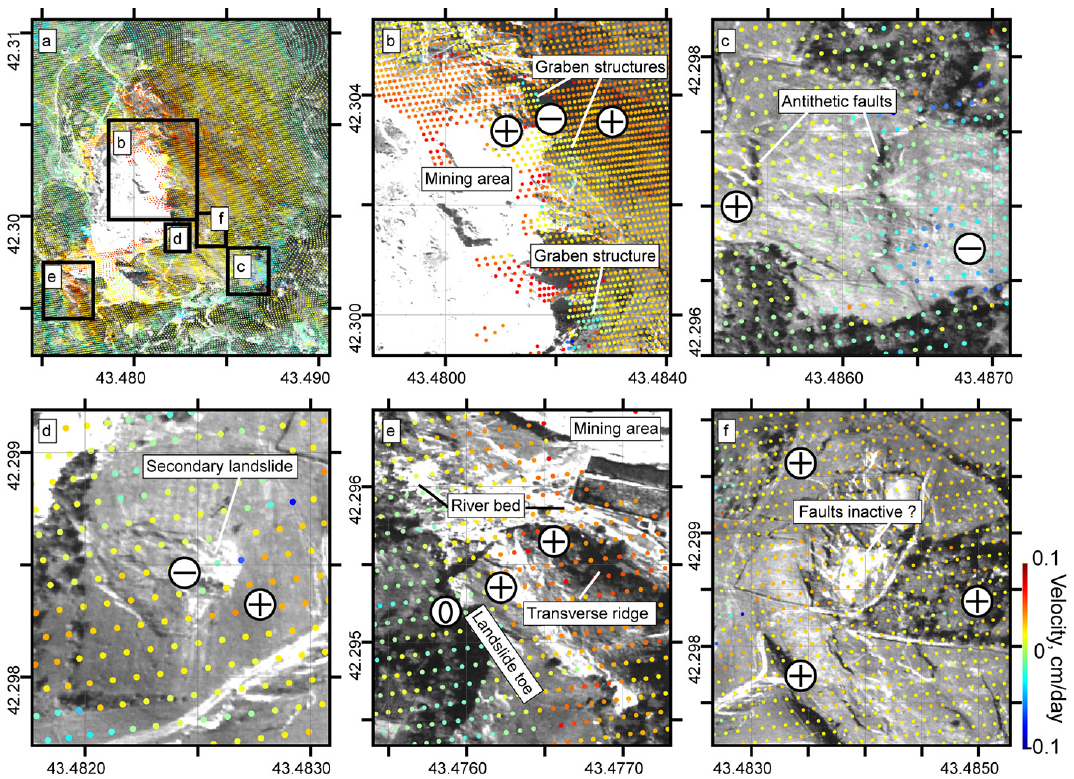
Fig. 5. (a) Aerial photography covered by a displacement map derived from InSAR. (b–f) details of the black boxes in (a) , allowing a comparison between the displacement map and the morphology. Red pixels show movement towards the satellite. See text for